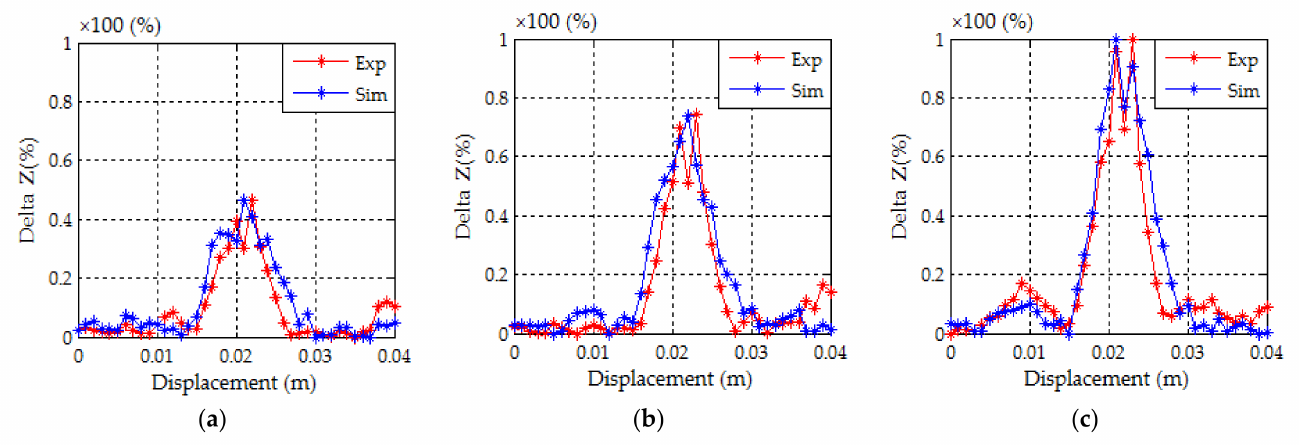
Figure 13. Impedance variation in (%) at 10 kHz with ( a ) depth = 0.3 mm, ( b ) depth = 0.5 mm, and ( c ) depth = 1 mm.